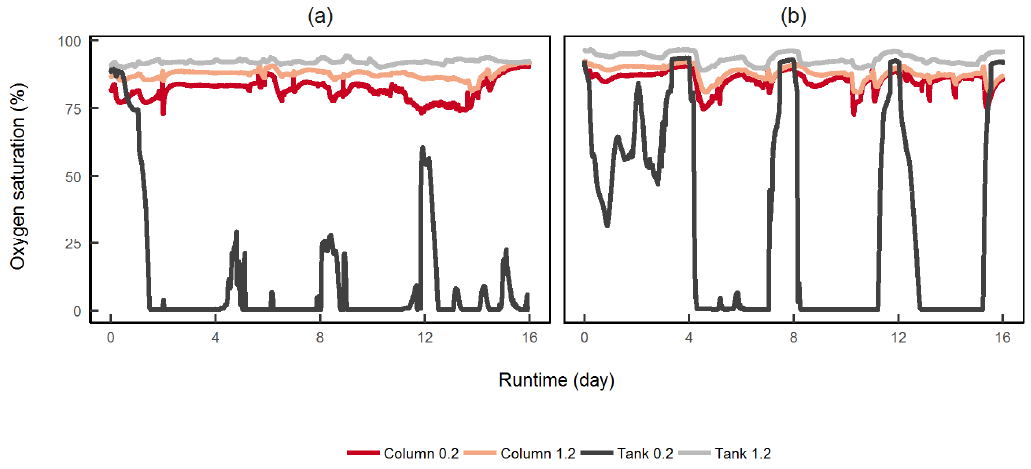
Figure 7. Oxygen consumption in point 0.2 and 1.2 during ( a ) scenario 3 (continuous infiltration) and ( b ) scenario 4 (wet/dry ration: 72 h/24 h) for column and tank.